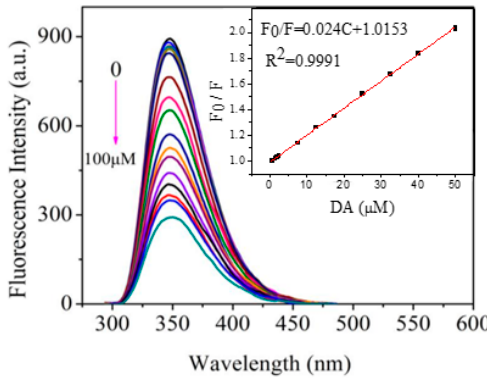
Figure 9. The quenching fluorescence spectra of the system by DA. Inset: calibration graph of the fluorescence quenching and different concentrations of DA.